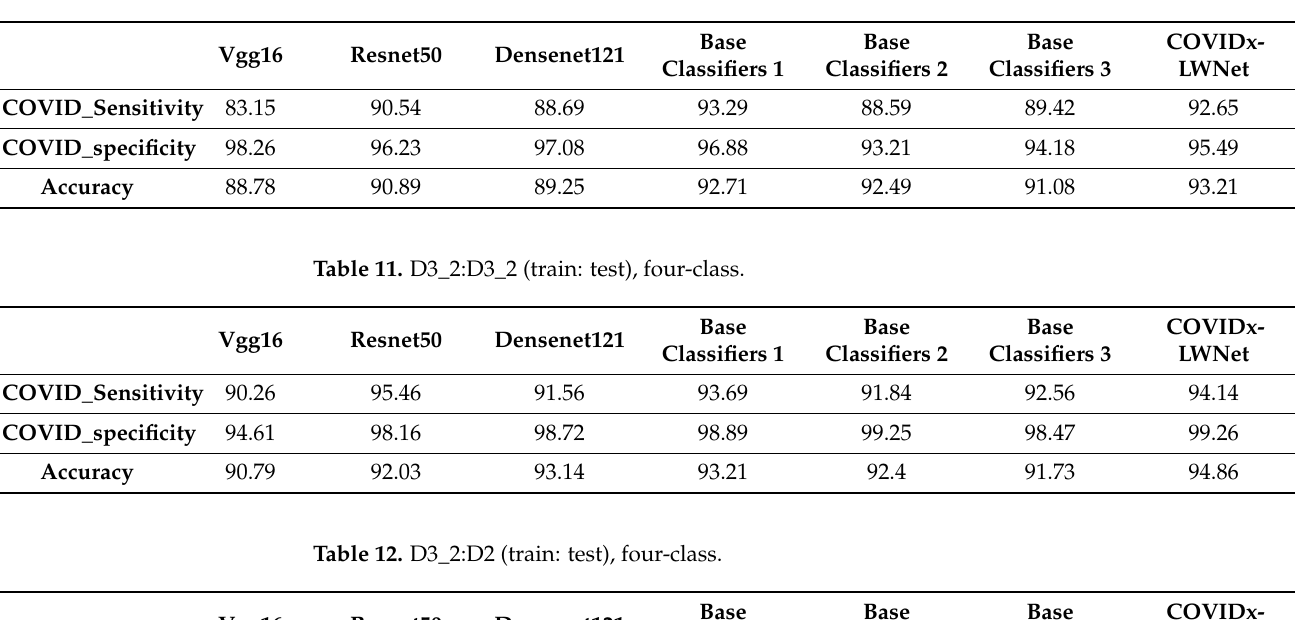
Table 10. D3_1:D1 (train: test), three-class.